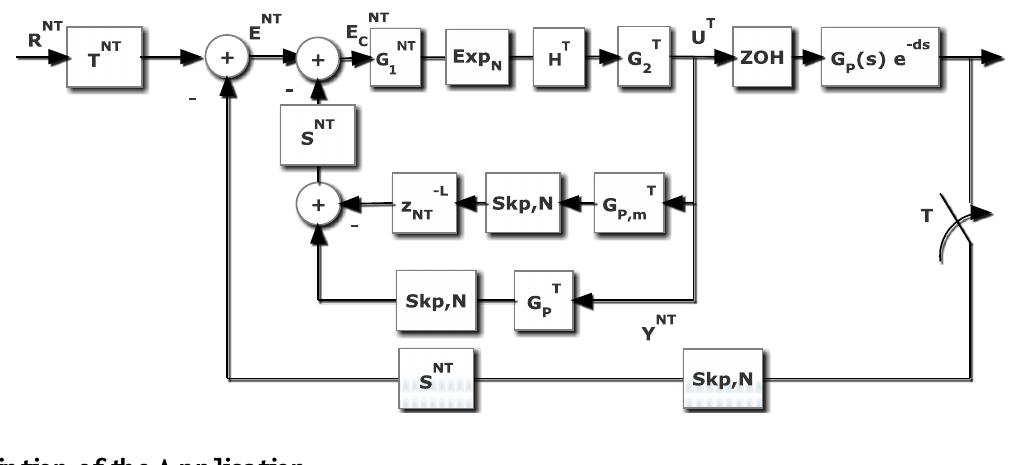
Figure 7. RST Controller in a loop with dead